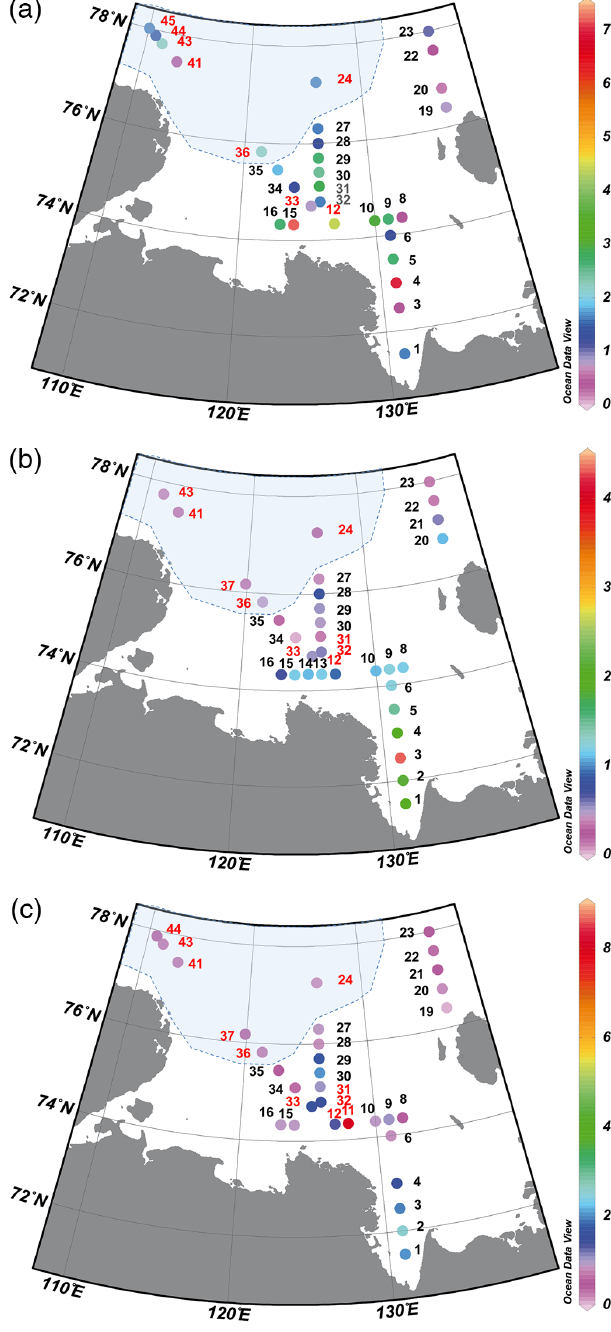
Figure 4. The overview on the TRANSDRIFT-XVII in-situ vari- ables (a) SPM (mgL − 1 ), (b) cDOM (absorption at 443nm, m − 1 ), and (c) Chl a (µgLµgL − 1 ) (upper 2m). The concentrations are colour-coded. The numbers indicate the TRANSDRIFT sampling stations NE10-01 to NE10-45: black-numbered stations could be used for the match-up analyses; red-numbered stations could not be used due to cloud coverage (the blue line indicates continuous cloud coverage throughout most years in the northwestern Laptev Sea). Please note that not all variables could be covered at all